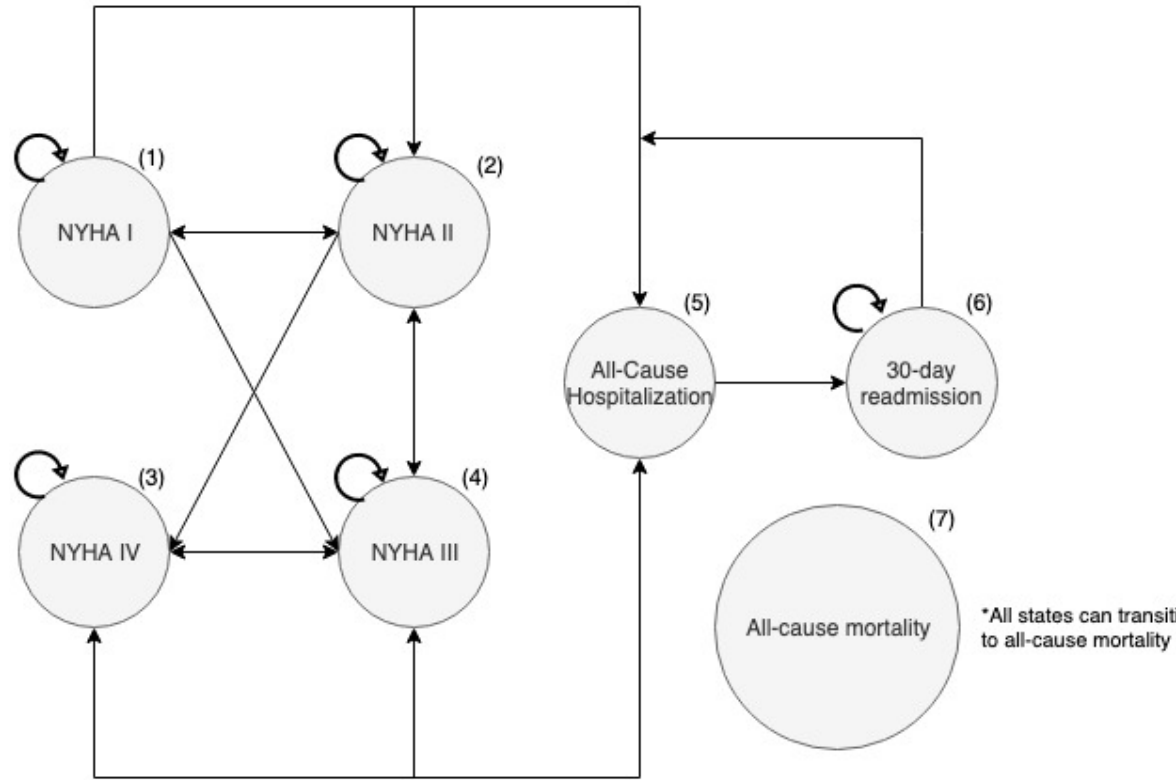
Figure 2. Conceptual representation of the microsimulation model structure. States 1 to 4 represent the transitions between New York Health Association classes. States 5 and 6 show transitions into and between hospitalization states. State 7 is an absorbing state representing death, where all states can transition to. NYHA: New York Health